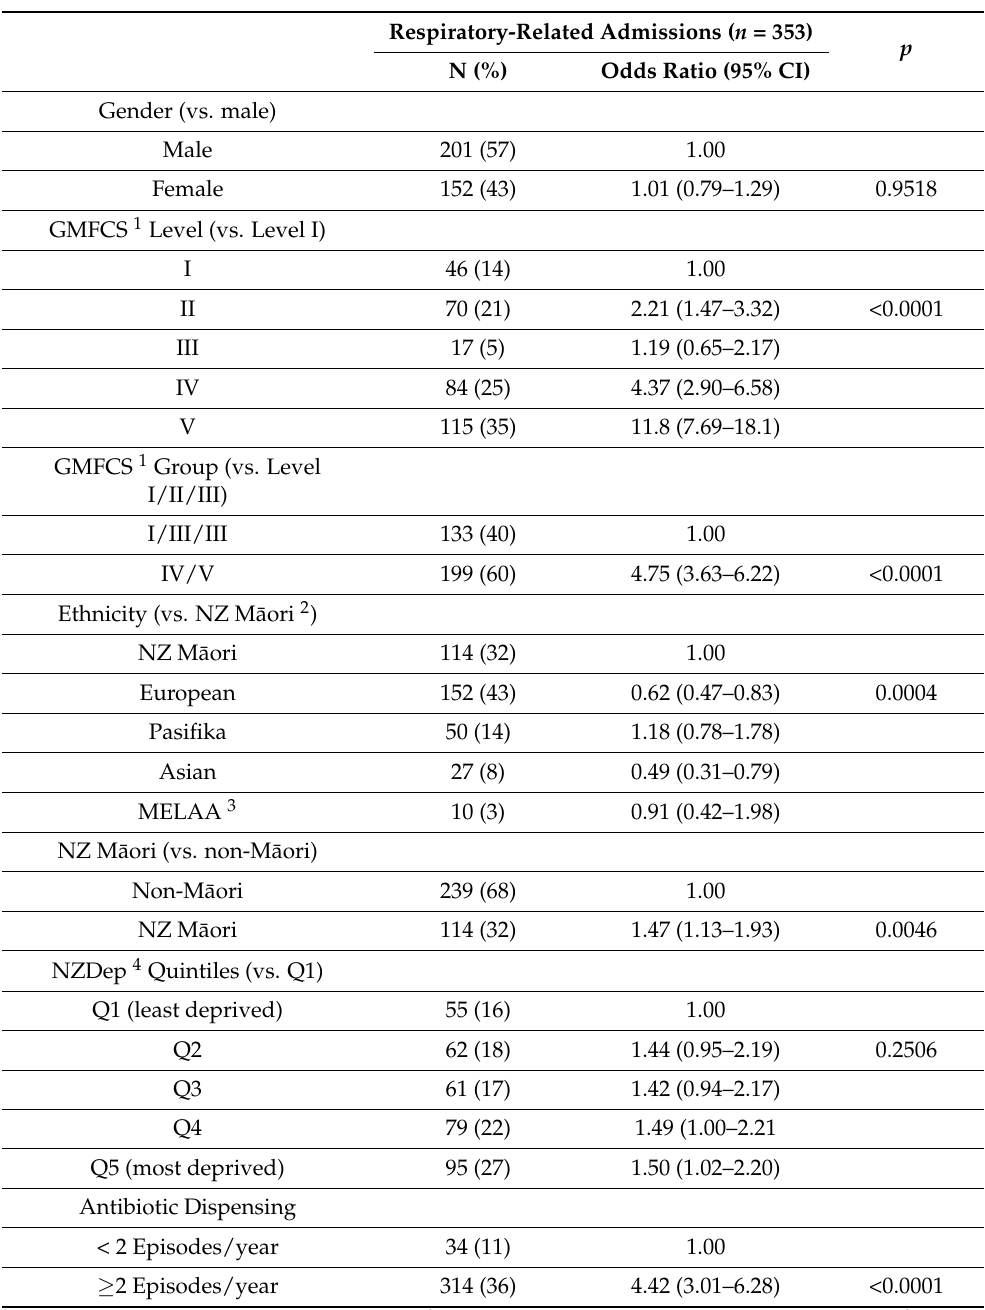
Table 3. Univariate regression analysis and odds ratio analysis for respiratory-related admissions for children and young adults with CP for gender, GMFCS, ethnicity, NZDep quintile variables, and if ≥ 2 antibiotics dispensed per